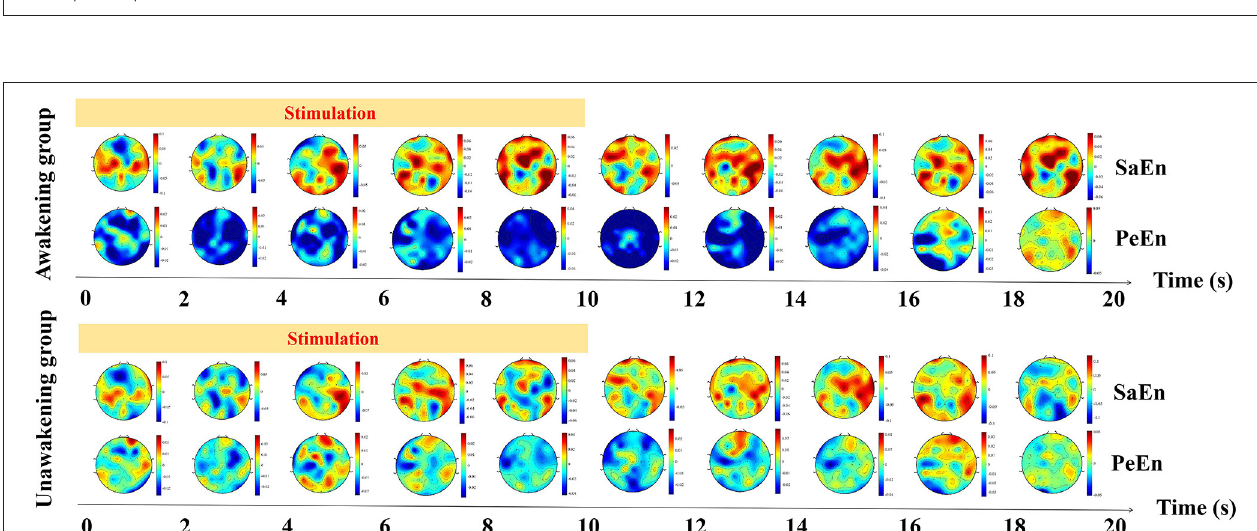
Frontiers in Neurology |